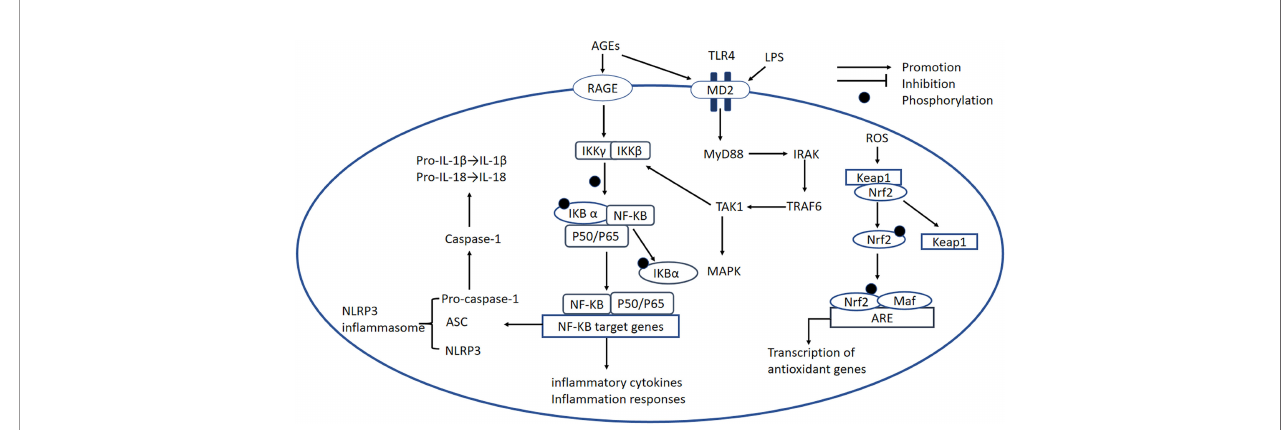
FIGURE 4 | NF- k B signaling pathway, the NLRP3 in fl ammasome, the TLR-MyD88 signaling pathway, and the Nrf2 signaling pathway. NF- k B signaling pathway: In DCM, AGEs bind to RAGE, which causes the activation of RelA (p65) or RelC-containing complexes. The phosphorylation of IKK b causes phosphorylation of I k B a and its degradation, leading to the release of NF- k B dimers. Phosphorylated NF- k B dimers bind to NF- k B DNA response elements and induce the transcription of target genes. NLRP3 in fl ammasome: The NLRP3 in fl ammasome complex is composed of NLRP3, ASC, and pro-caspase-1. ROS and activated NF- k B can activate the NLRP3 in fl ammasome. The activated in fl ammasome prompts ASC to cleave pro-caspase-1 to active caspase-1, which induces the maturation of IL-1 b and IL- 18, thereby inducing an in fl ammatory response. TLR4-MyD88 signaling pathway: AGE production is induced by OS and high glucose concentrations, and AGEs bind to MD2, leading to the formation of a TLR4/MD2 complex, which activates MyD88. In turn, MyD88 activates IRAKs and TRAF6, which activates TAK1 and the transcription factors MAPK and NF- k B. This transcription factor induces proin fl ammatory cytokine gene expression. Nrf2 signaling pathway: Nrf2 binds to its inhibitory protein Kelch-like ECH-associated protein-1 (Keap1) to form a stable complex. When it is activated by OS, Nrf2 is released and phosphorylated, and activated Nrf2 is translocated to the nucleus where it binds to antioxidant-responsive elements (AREs), initiating the transcription of antioxidant genes, including heme oxygenase-1(HO-1) , NAD(P)H dehydrogenase, SOD, and catalase . NF- k B, nuclear factor- k B; IKK b , IkB kinase b ; NLRP3, NOD-like receptor thermal protein domain- associated protein 3; ASC, apoptosis-associated speck-like protein containing a CARD; pro-caspase-1, pro-cysteinyl aspartate speci fi c proteinase-1; MD2, myeloid differentiation-2; MyD88, myeloid differentiation primary response protein 88; IRAK, IL-1 receptor-associated kinase; TRAF6, TNF receptor-associated factor 6; TAK1, transforming growth factor-activated kinase 1; MAPK, mitogen-activated protein kinase; Nrf2, nuclear factor erythroid 2-related factor 2; Keap-1, Kelch-like ECH- associated protein-1; AREs, antioxidant-responsive elements; HO-1, heme